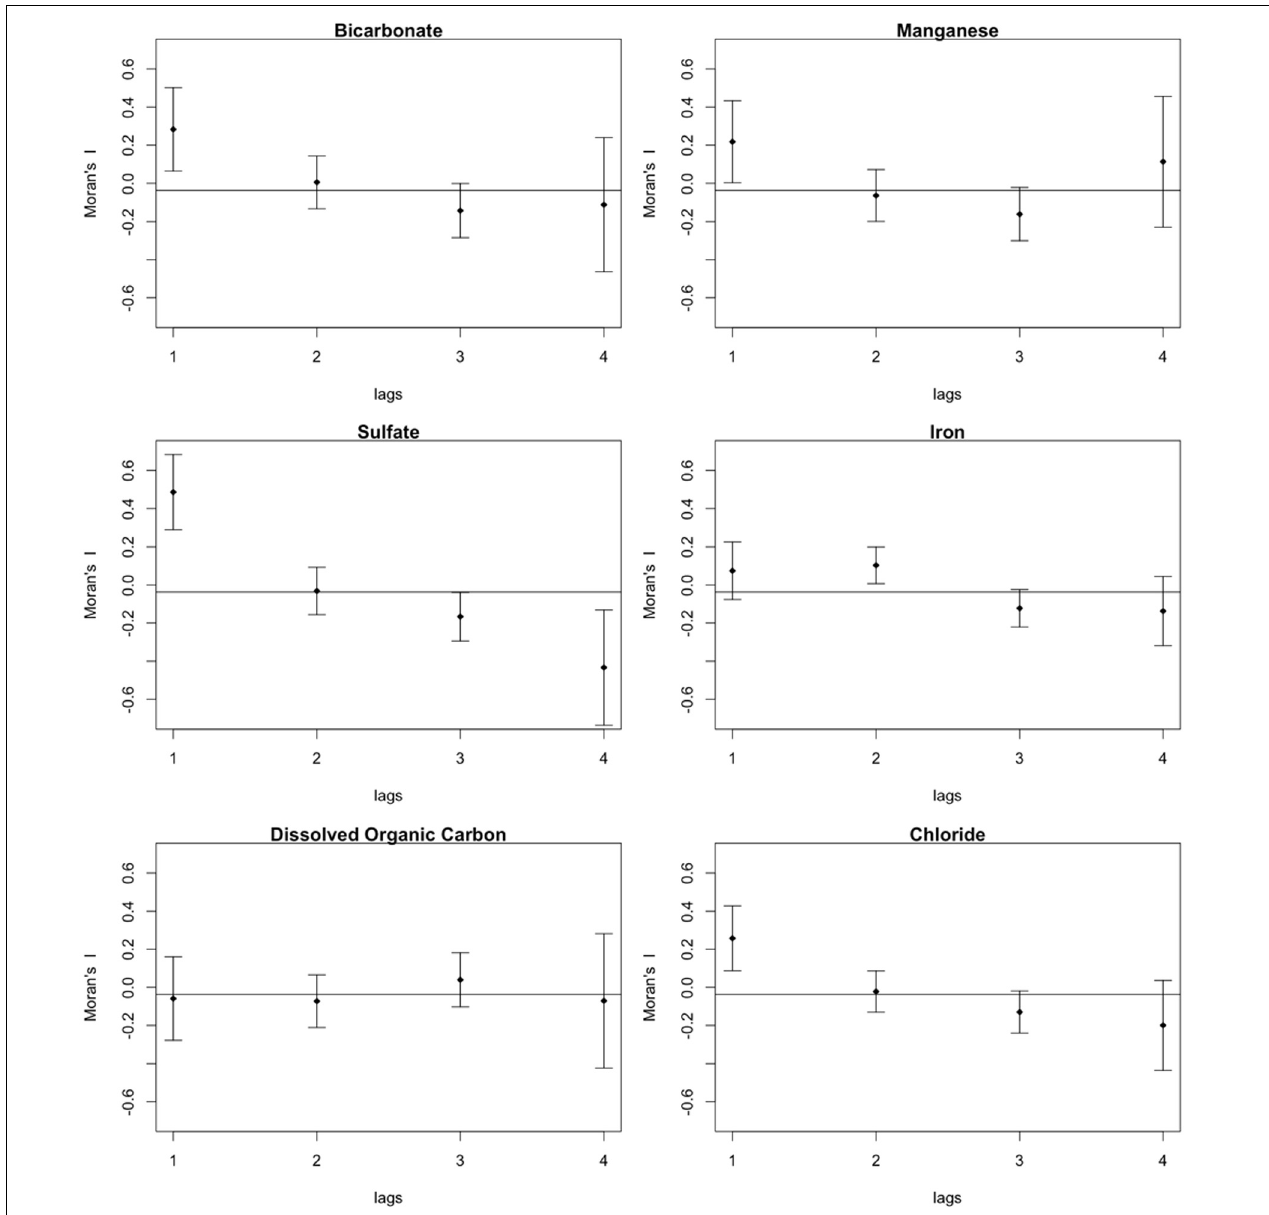
FIGURE 7 | Moran’s I correlogram showing spatial correlation of some major groundwater components; bicarbonate, manganese, sulfate, chloride, and iron, but not for dissolved organic